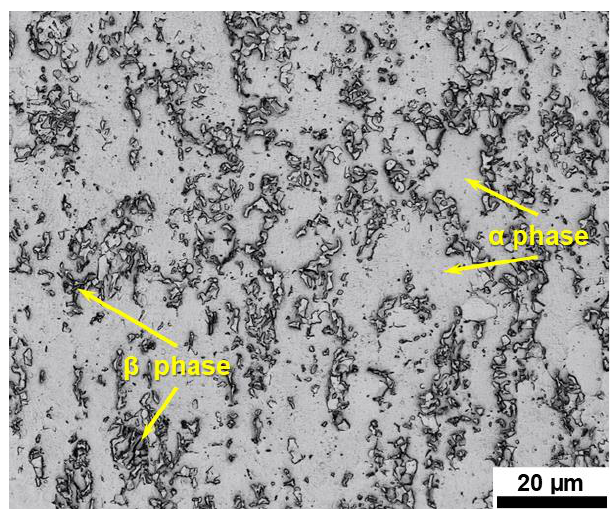
Figure 5: Optical micrograph of the as-built Ti6Al4V alloy. α and β phases highlighted with yellow lines. Etching: Kroll’s